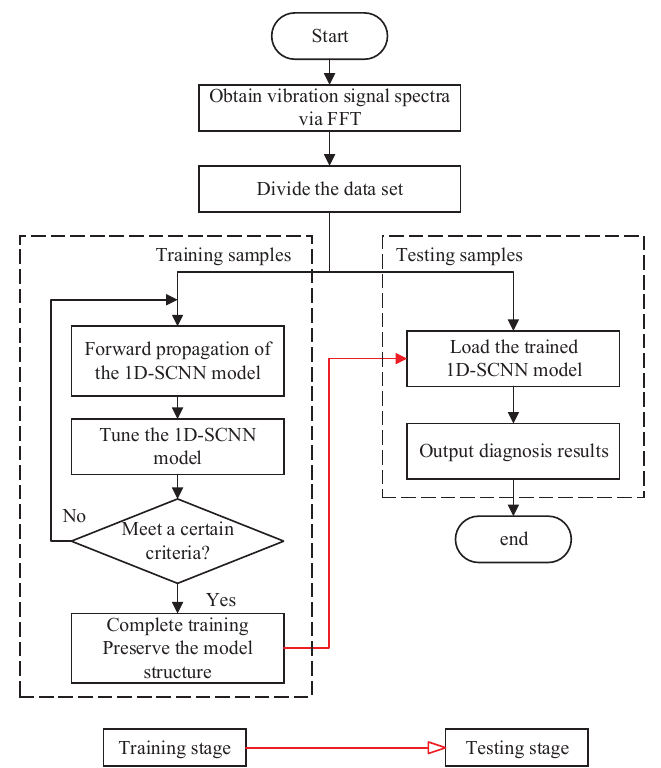
Figure 4. Flow diagram of 1D-SCNN-based fault diagnosis method of rotating